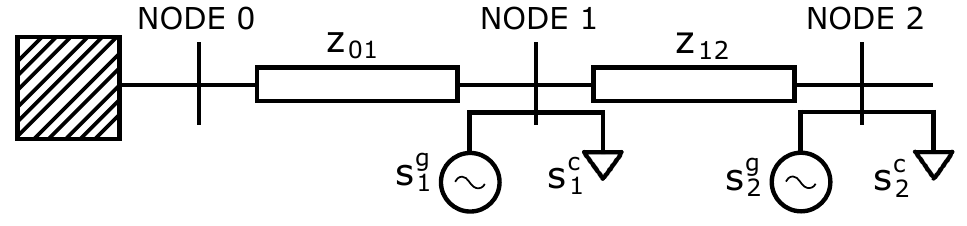
Figure 1. Example 3-bus